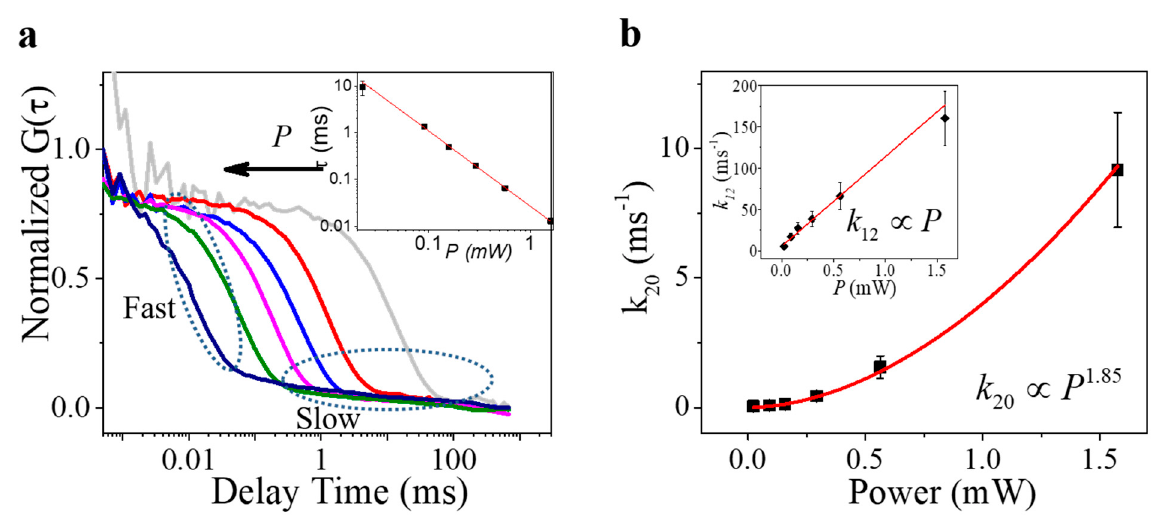
Figure 5. Power-dependent ACF analysis. ( a ) Normalized ACF curves calculated from the time trajectory obtained in Figure 4(a). Two components are found in all curves, including a fast component (10~1000 μ s) and a slow one (~30 ms). ( b ) Power-dependent |2>-to-|0> transition rate k 20 of the fast component in ( a ), which is fitted by a power equation with the index 1.85; inset plot of the |1>-to-|2> transition rate k 12 versus the excitation laser power.